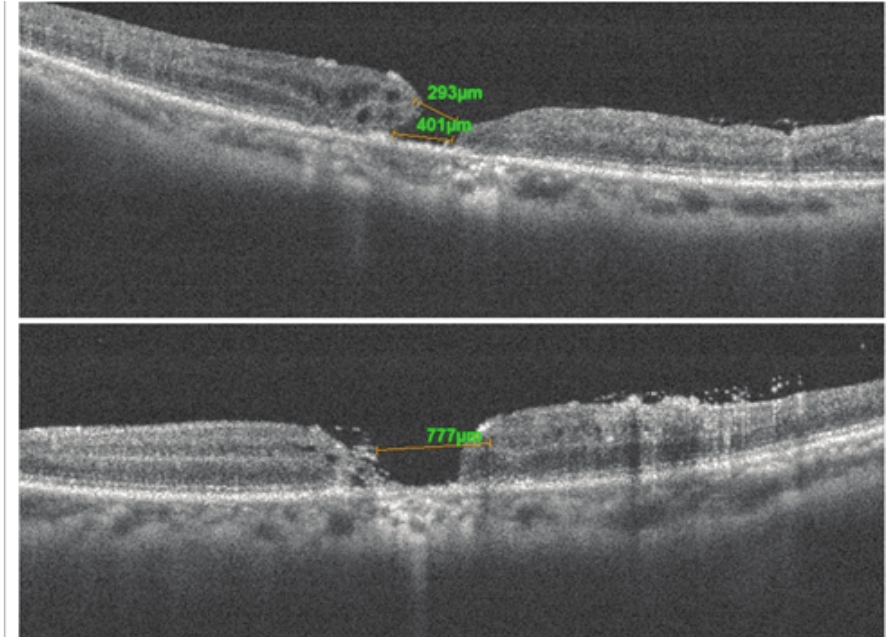
Figure 7. Patient 3; preoperative OCT cross-line horizontal and vertical scans of the macular hole. Emulsified silicon oil is present on the retinal surface and within the macular